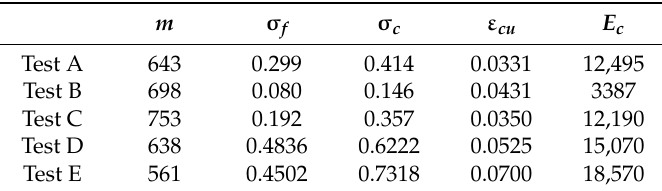
Table 3. Summary of the mechanical tests